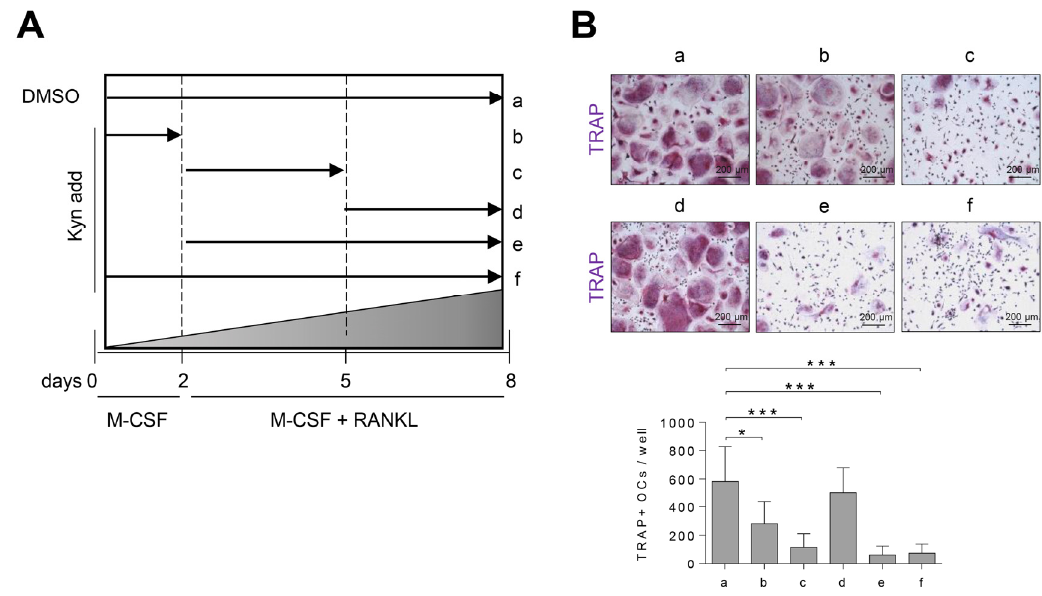
Figure 3. Kyn suppresses osteoclast formation at an early stage of differentiation. ( A , B ) In the absence (a) or presence (b–f) of Kyn (100 µ M) for the indicated time, human PBMC CD14+ cells were cultured with M-CSF (20 ng/mL) for 2 days, and then RANKL (40 ng/mL) was added for 6 days. The cells were stained with TRAP on day 8, and the TRAP+ osteoclasts were counted. Images were taken at original magnification 100 X. Scale bar is 200 µ m. Data are shown as mean ± SD of five independent experiments and a one-way ANOVA test was applied. * p < 0.05, *** p < 0.001.